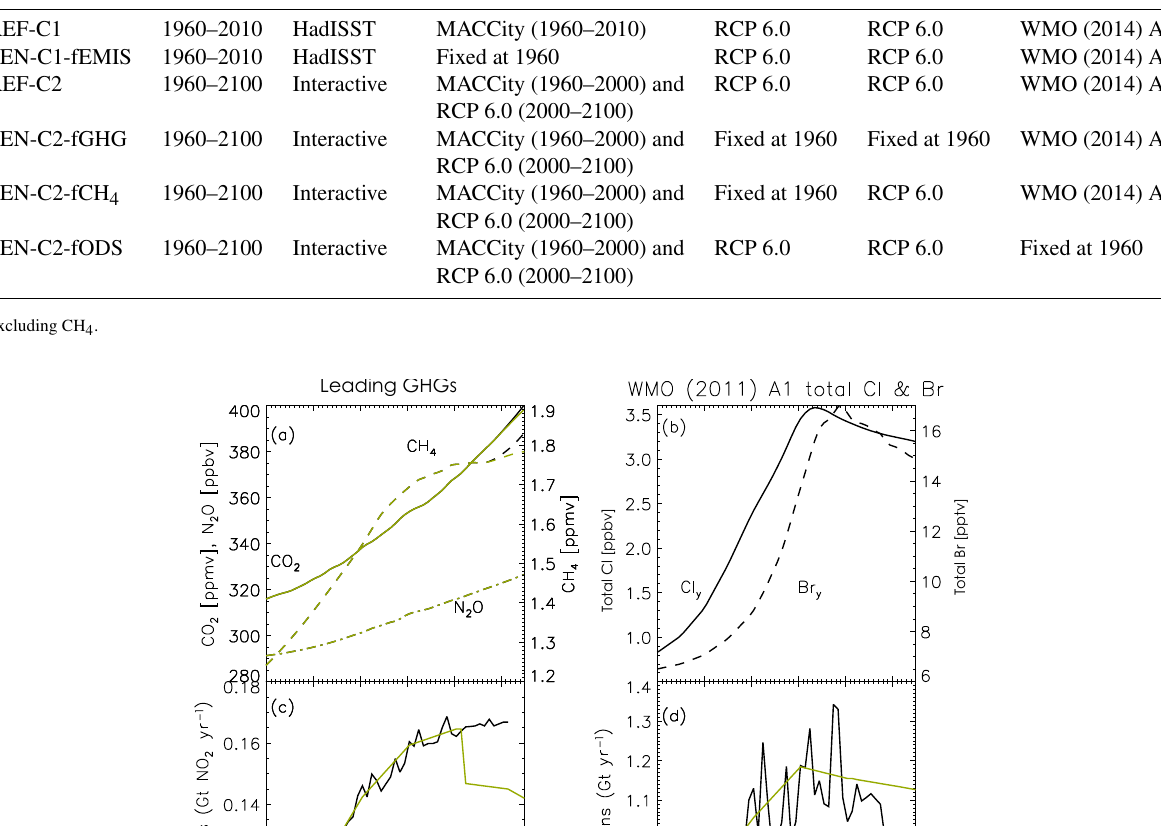
Table 1. Chemistry-Climate Model Initiative (CCMI) simulations performed by NIWA-UKCA, used in this study. Simulation